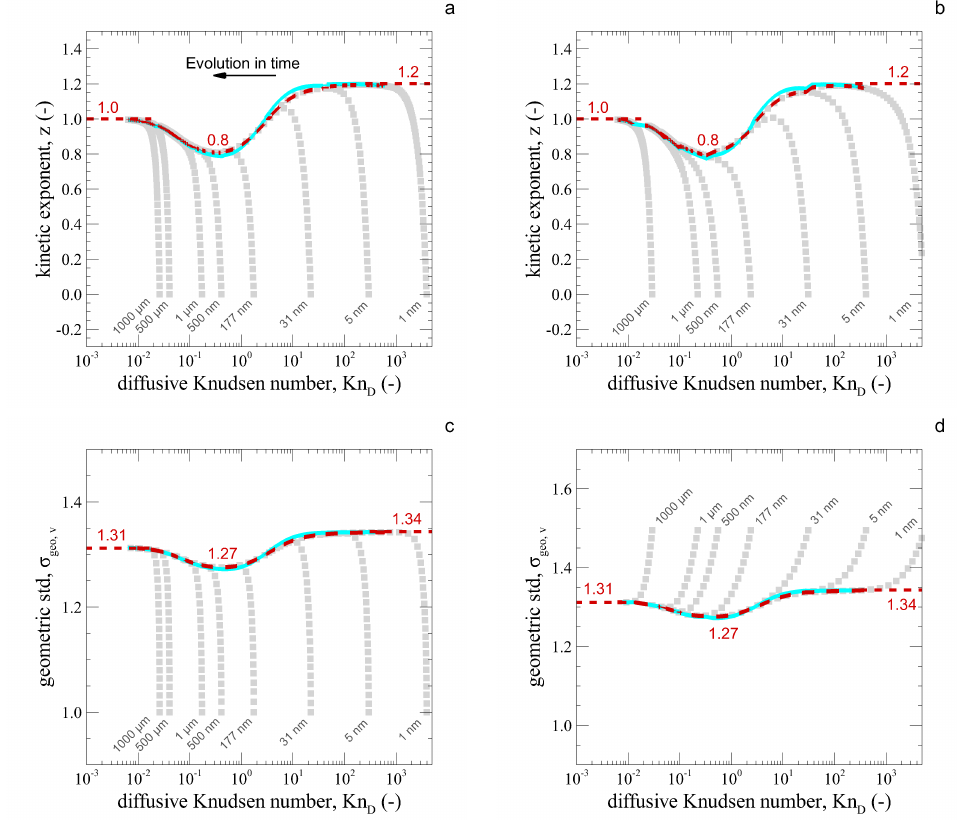
Figure 7. The kinetic exponent ( z ) of coagulating monodisperse ( a ) and polydisperse ( b ) spherical particles as a function of the diffusive Knudsen number. The volume-equivalent diameter geometric standard deviation for initially σ geo,v = 1 monodisperse ( c ) and σ geo,v = 1.5 polydisperse ( d ) particles is also shown. Gray filled symbols represent the z for all simulation in time. The particle diameter is indicated for each curve. The asymptotic red-dashed curve obtained by the reference method [12] is compared to the cyan continuous line obtained by using the proposed